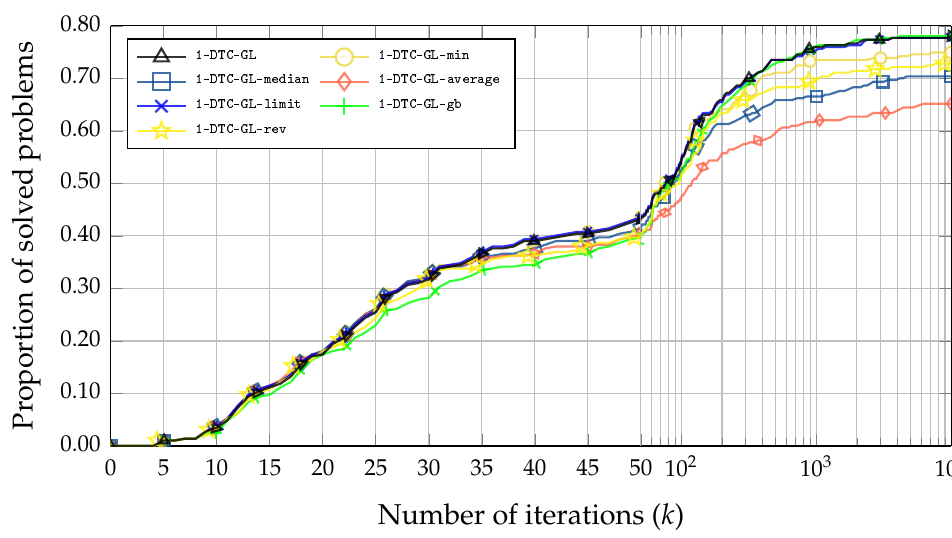
Figure 5. Operational characteristics based on the number of iterations for all seven 1-DTC-GL algorithmic variations on the whole set of DIRECTGOLib v1.2 test